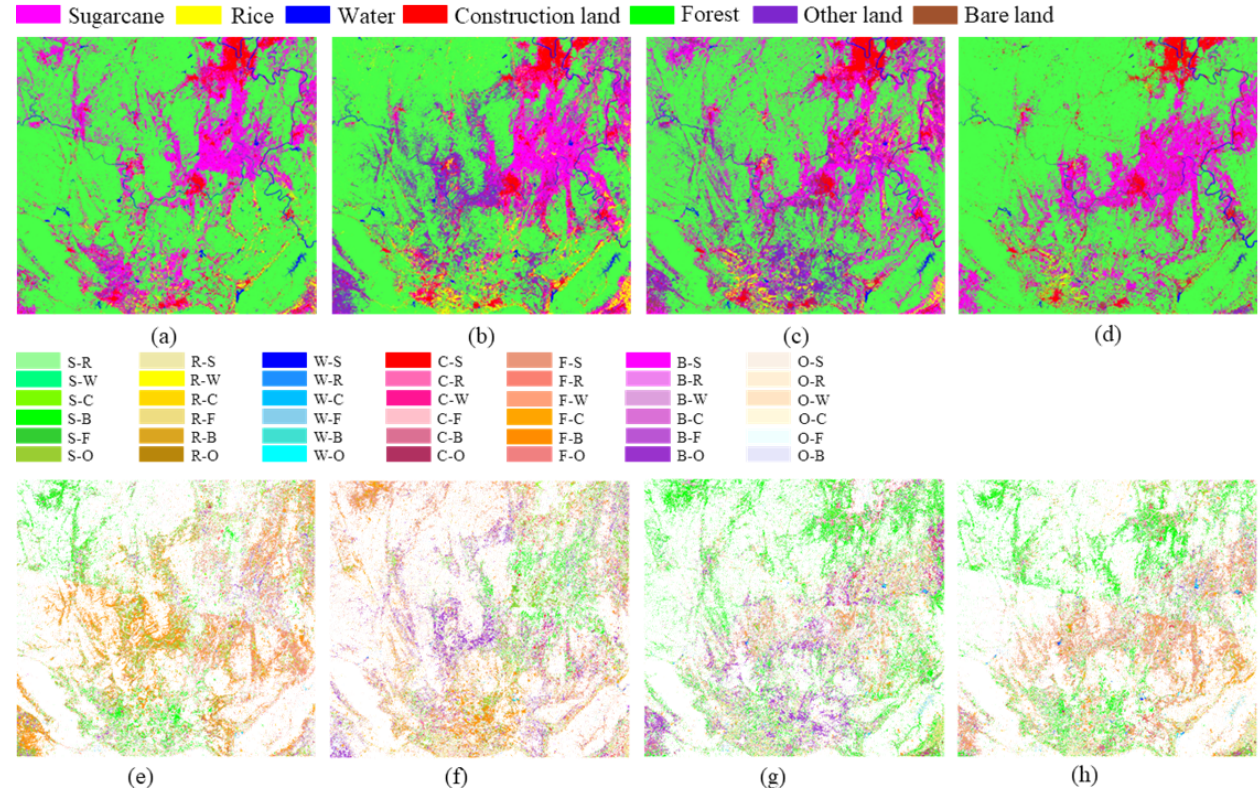
Figure 15. Semantic segmentation results on the test set in the 2021 dataset I produced by: ( a ) U-Net, ( b ) U-Net++, ( c ) SAR-UNet, ( d ) Res-UNet++, ( e ) Attention-UNet, ( f ) UCTransNet, ( g ) Swin-UNet, and ( h ) SA-UNet.